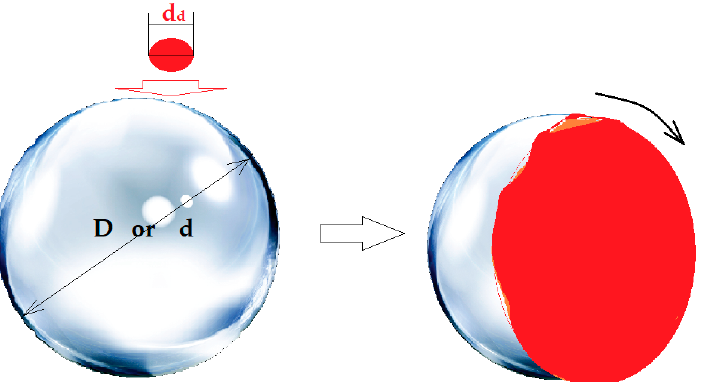
Figure 9. Transformation of the aqueous phase drop into a film on the surface of the considered contact sphere. Table 3. Comparative flows of aromatic derivatives through membrane systems.